Question: Express in one sentence what the figure is showing.
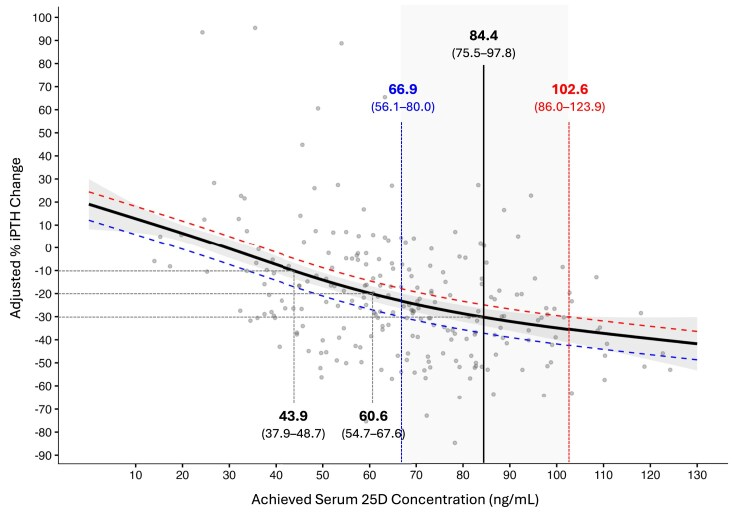
Answer: Population-average exposure–response relationships between achieved serum 25-hydroxyvitamin D (25D) and % change in intact parathyroid hormone (iPTH). The solid black curve represents the marginal mean response, and the shaded band indicates the 95% CI. The solid vertical line indicates population-average 25D concentration associated with a 30% iPTH reduction. Dashed curves represent population-average estimates with estimated glomerular filtration rate (eGFR) fixed at the 5th percentile (red) and the 95th percentile (blue) and vertical dashed lines indicate the corresponding 25D concentrations associated with a 30% reduction in iPTH under each scenario. Vertical grey dashed lines indicate population-average 25D concentrations associated with 10% and 20% reductions in iPTH.